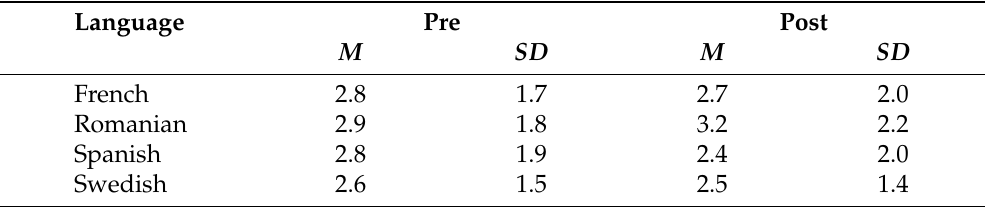
Table A11. I rely on my own knowledge and/or expertise on the subject.